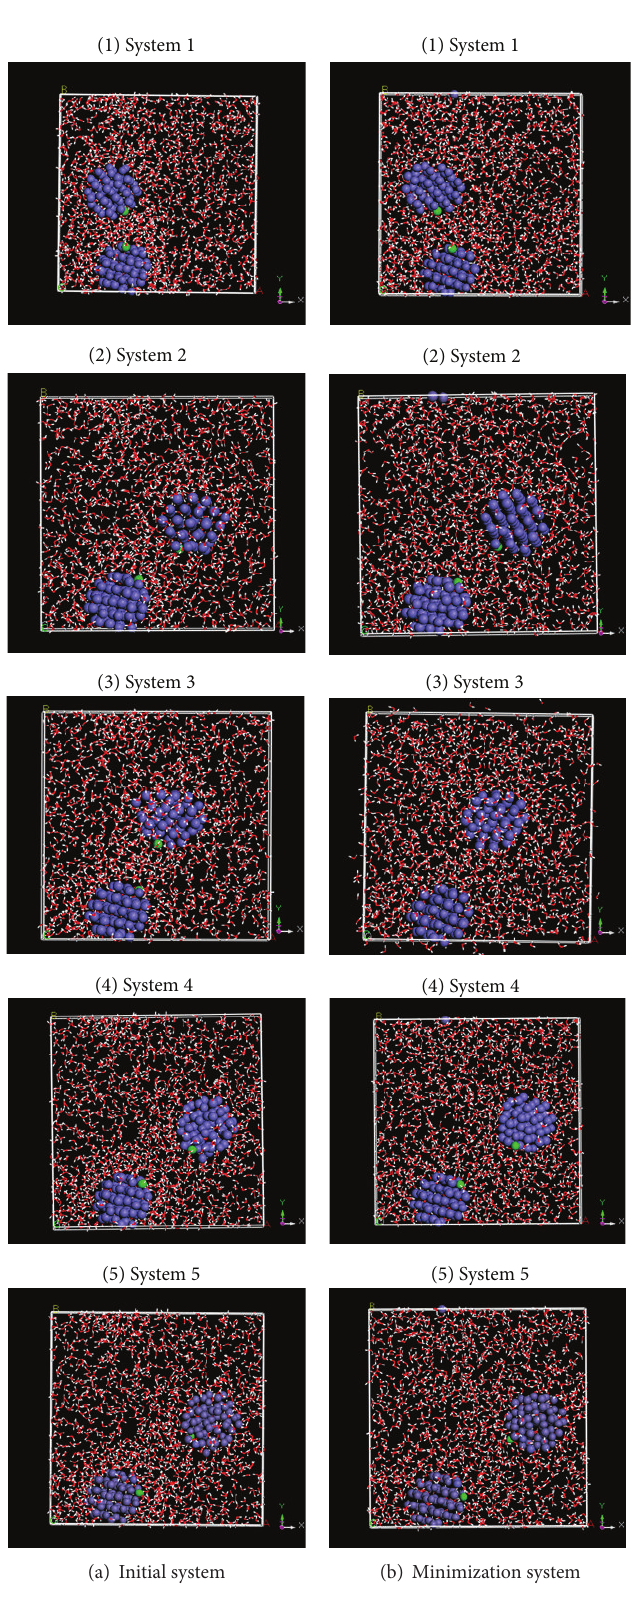
Figure 5: Conformations of initial system and minimization system of systems